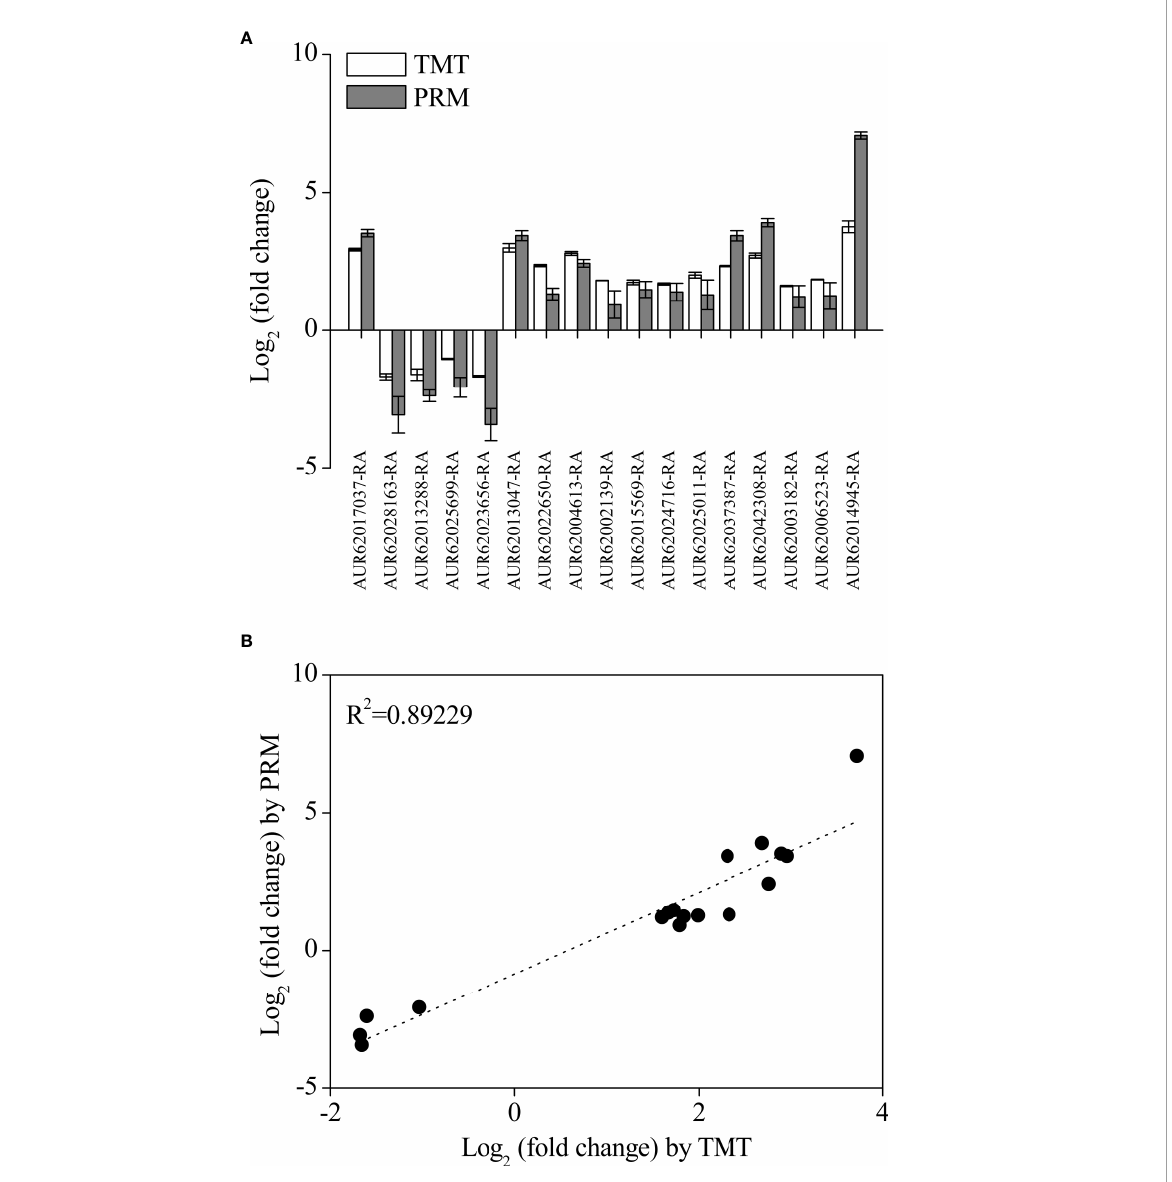
FIGURE 6 Changes in the 17 selected differentially accumulated proteins (DAPs) through tandem mass tag and parallel reaction monitoring analysis (A) and their correlation analysis (B) in quinoa from different developmental stages. The selected DAPs, including ABA-inducible protein PHV A1 (AUR62017037-RA), beta-amylase (AUR62014945-RA), 13S globulin seed storage protein 1 (AUR62002139-RA and AUR62015569-RA), 11S globulin seed storage protein 2 isoform X2 (AUR62024716-RA), vicilin-like seed storage protein At2g18540 (AUR62003182-RA), vicilin-like seed storage protein At2g28490 isoform X2 (AUR62006523-RA and AUR62025011-RA), seed biotin-containing protein SBP65 (AUR62037387-RA and AUR62042308-RA), late embryogenesis abundant protein (family protein (AUR62022650-RA and AUR62004613-RA), early-responsive to dehydration 7, chloroplastic (AUR62013047-RA), b -amyrin 28-oxidase (AUR620256 99-RA), anthocyanidin 3-O-glucosyltransferase 7 (AUR62028163-RA), bifunctional purple acid phosphatase 26 (AUR62013288-RA), and cyprosin (AUR62023656-RA). The data are presented as the mean ± SE of three replicates ( p <